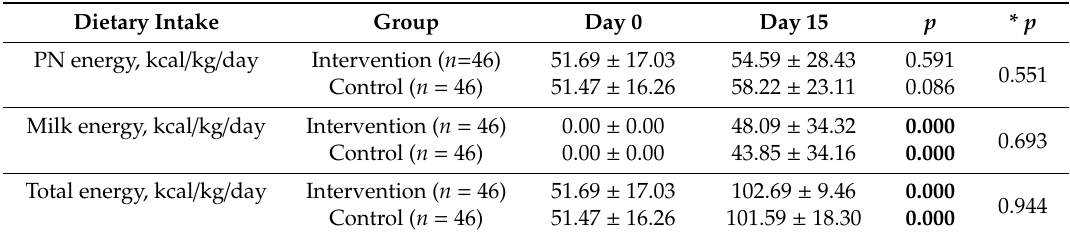
Table 2. Changes in dietary energy intake at baseline (day 0) and at the endpoint of intervention (day 15) in the SO-IVFE group and the MCT / ω -3 PUFAs-IVFE group.